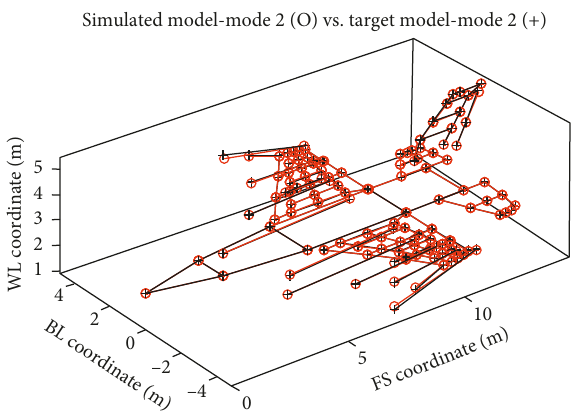
Figure 34: Mode shape for configuration 1 mode-2.